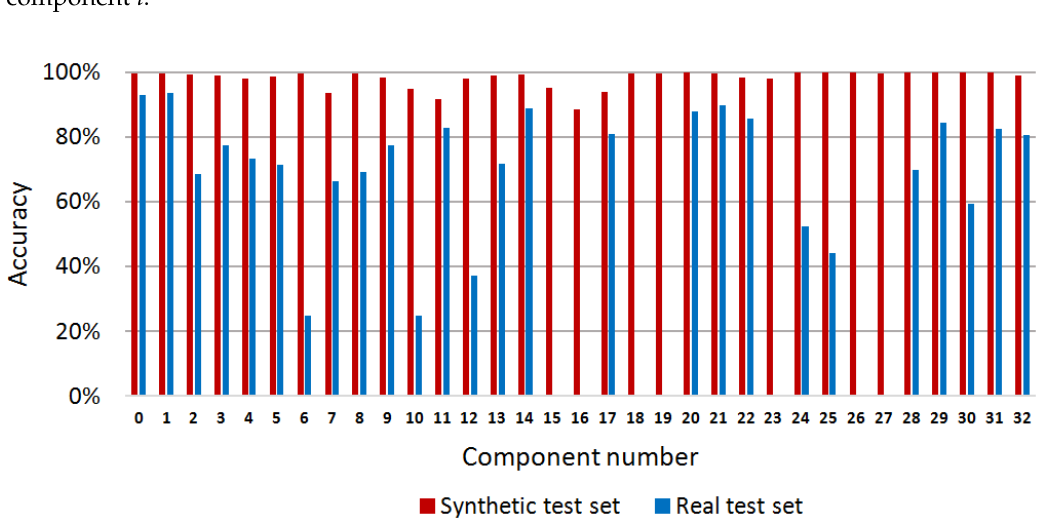
Figure 7. Pixel classification accuracy of the random forest classifier for each PCB component on synthetic and real data.